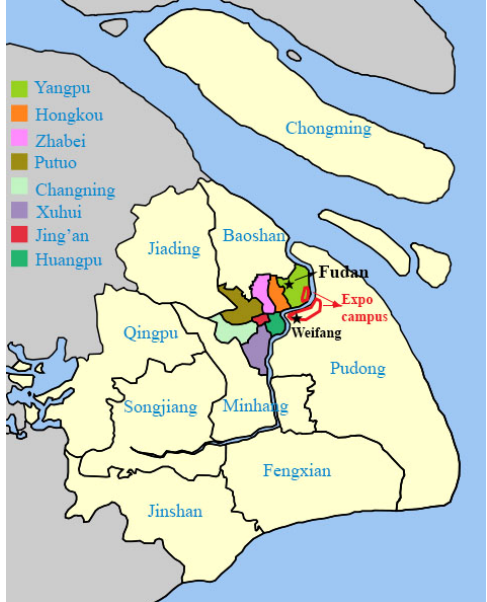
Fig. 1. Map of Shanghai with district borders. The area of the expo campus is shown by the red polygon, and the monitoring sites at Fu- Figure.1. Map of Shanghai with district borders. The area of the Expo campus is shown by the red polygon, and the monitoring sites at Fudan and Weifang are denoted by the black stars (This figure is dan and Weifang are denoted by the black stars (This figure is modi- modified based on the map from http://en.wikipedia.org/wiki/Shanghai). 841 fied based on the map from